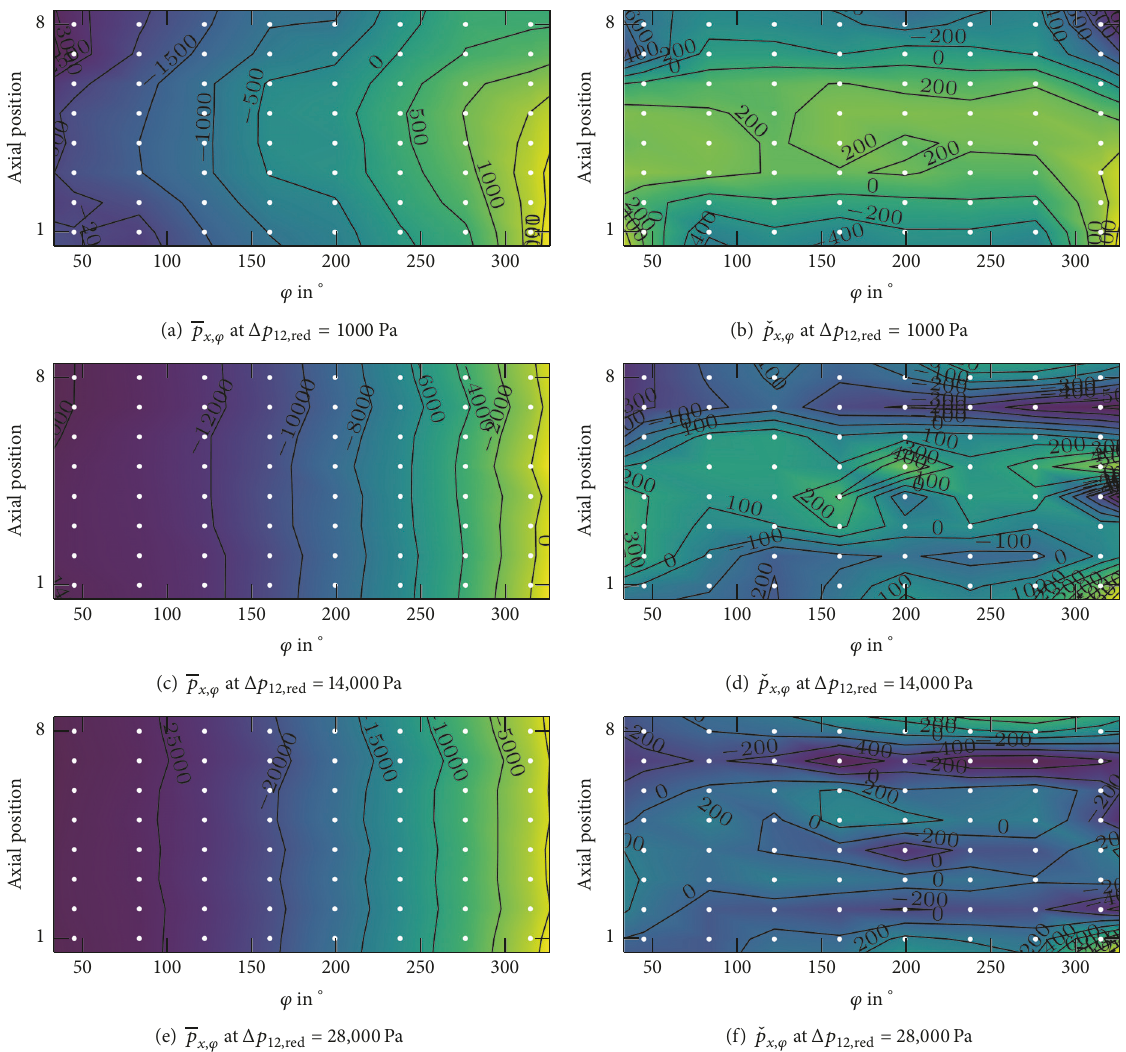
Figure 15: Wall pressure distribution at a rotational speed of 50Hz for different operating points. (a, c, e) Static pressure relative to ambient pressure 𝑝 𝑥,𝜑 . (b, d, f) Local mean value-adjusted static pressure relative to ambient pressure ̌𝑝 𝑥,𝜑 according to equation